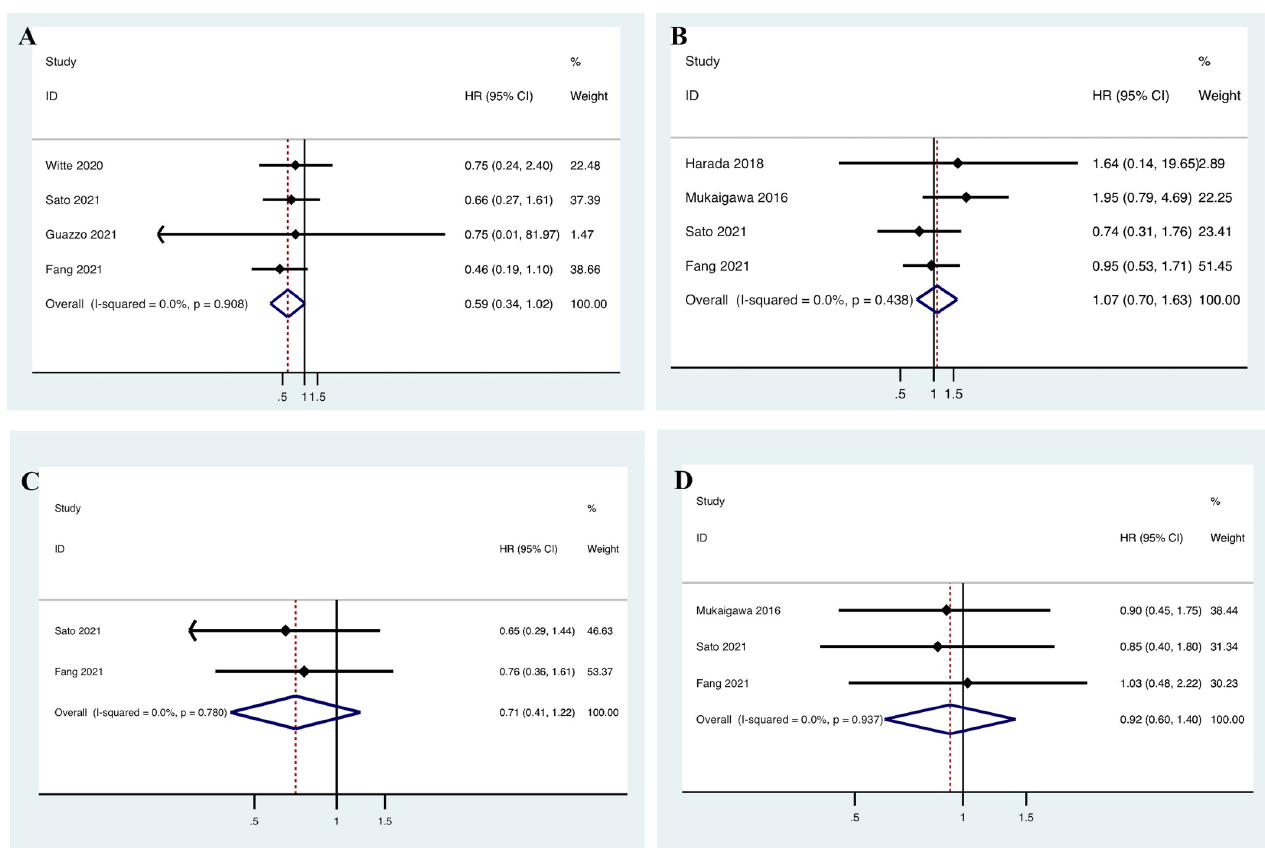
Fig 4. Meta-analysis of the prognostic role of PD-L1 expression for the overall survival (OS) and the disease-free survival (DFS) in salivary gland carcinoma (SGC) based on (A, C) combined positivity score (CPS); and (B, D) immune cell (IC). HR, hazard ratio; CI: confidence interval.